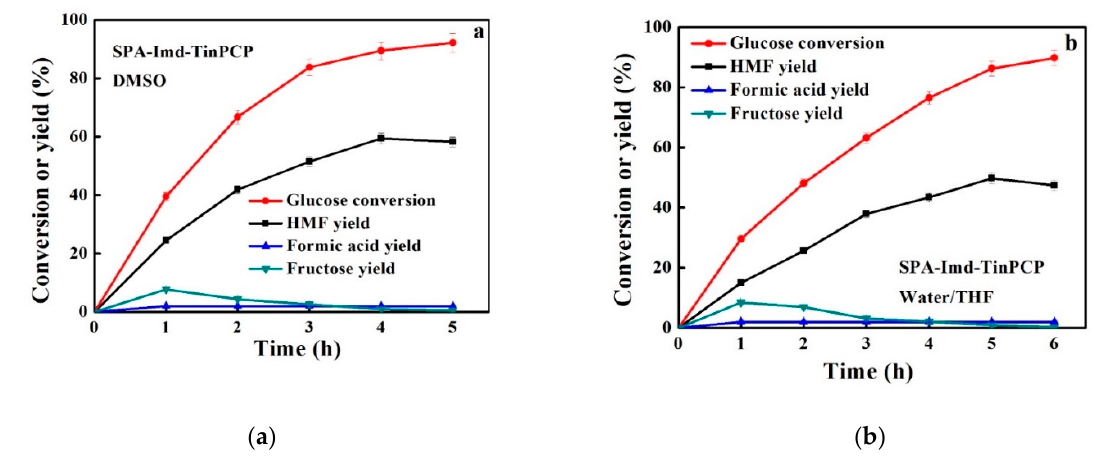
Figure 10. Glucose conversion, fructose, and HMF yields versus reaction time ( a ) DMSO; ( b ) H 2 O / THF. The working pressures were 1 atm and 5 atm for the DMSO and H 2 O / THF systems, respectively.